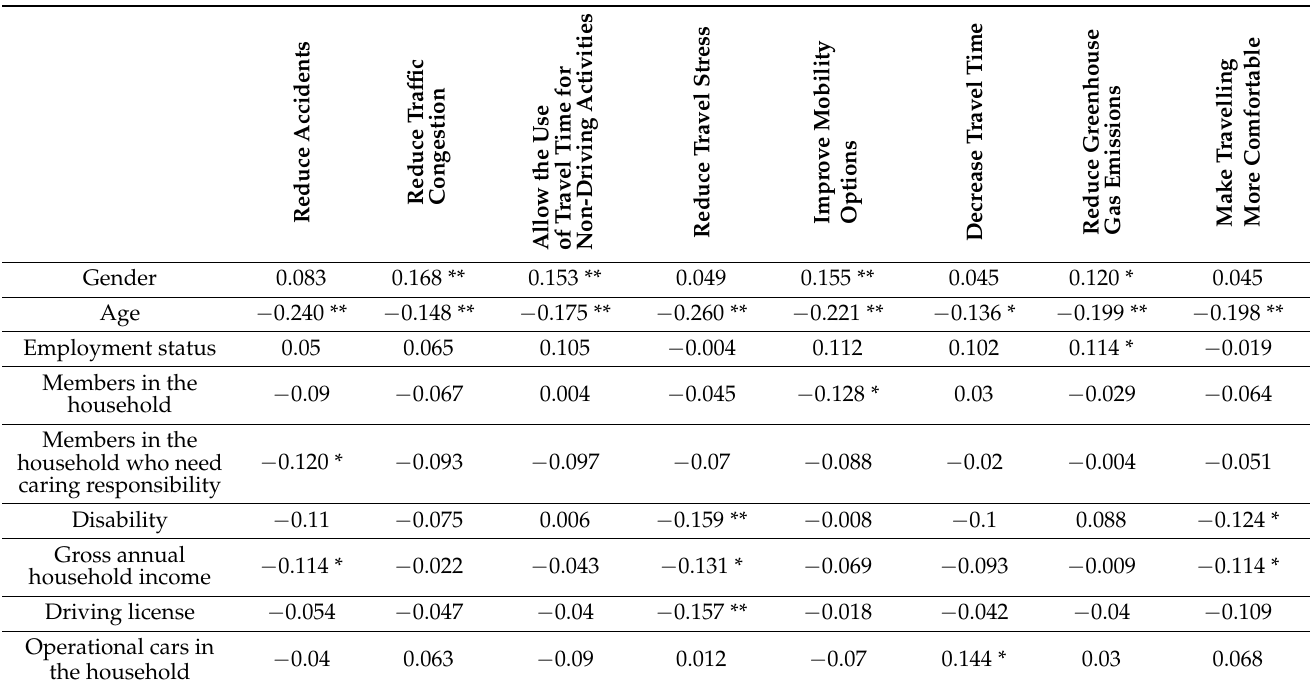
Table 10. Spearman correlation between socio-economic characteristics of the sample and potential benefits of AVs (Source: Authors’ survey